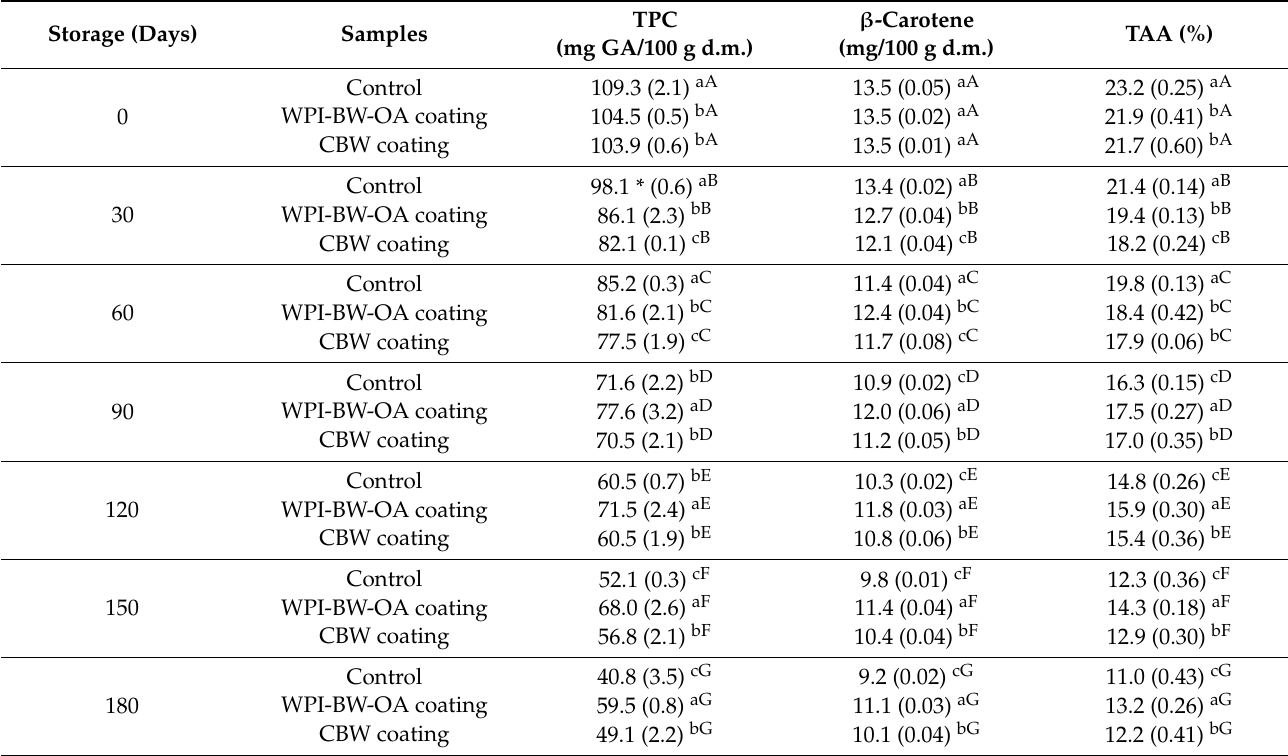
Table 2. Effect of different types of composite coating after HAD and storage time on bioactive compounds of semi-moist dried